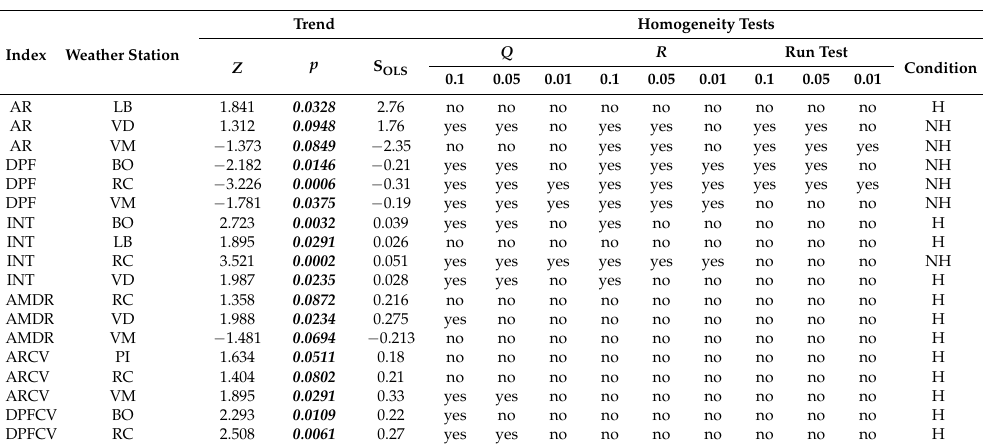
Table 3. Classification of rainfall series with significant trend ( Z values and their probability ( p < 0.10) and slope estimated by ordinary least squares (S OLS )) according to the homogeneity condition assessed under different criteria (yes: